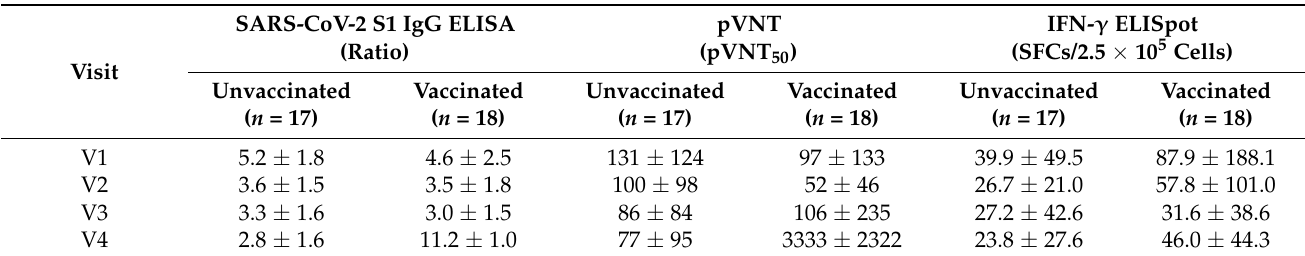
Table 2. Mean values of the humoral and cellular immune responses in SARS-CoV-2-recovered individuals with or without a single-dose